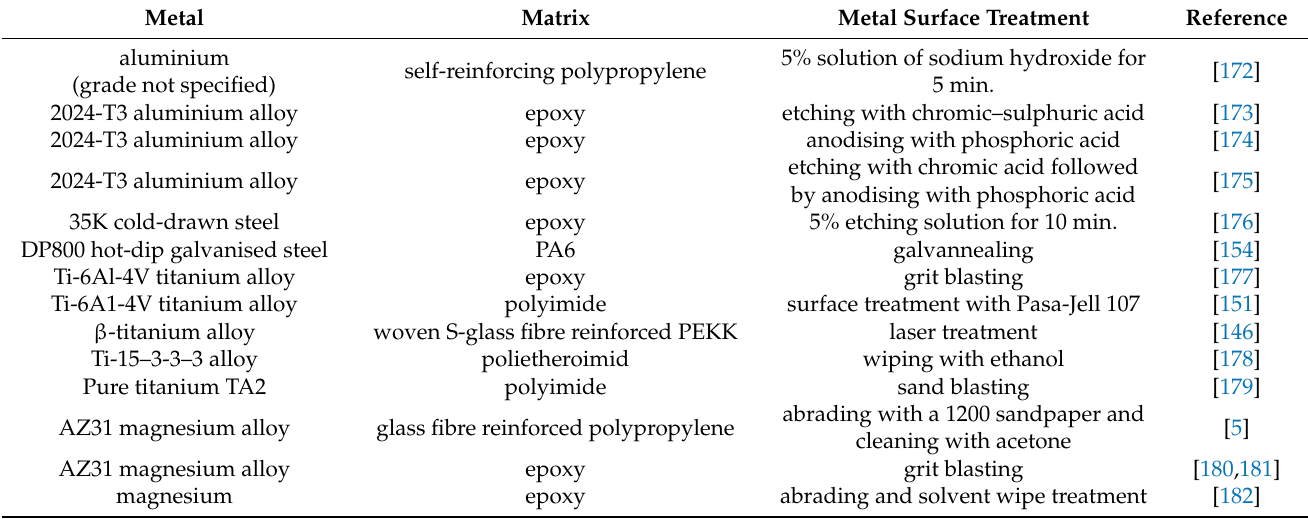
Table 2. Review of surface treatments in the manufacture of fibre metal